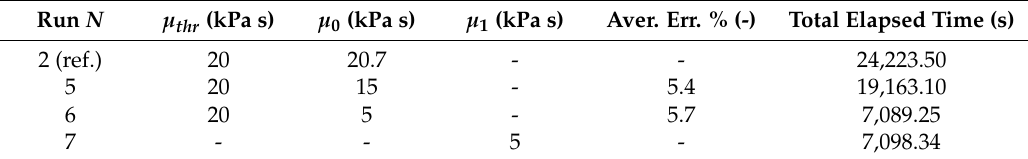
Table 2. Summary of the runs performed for numerical optimization with respect to limiting viscosity case their viscosity values are higher than µ 1 (green line in Figure